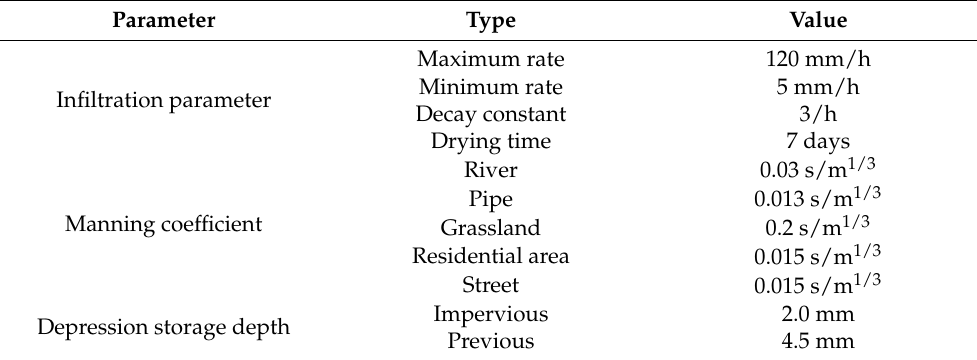
Table 5. The calibrated parameters.